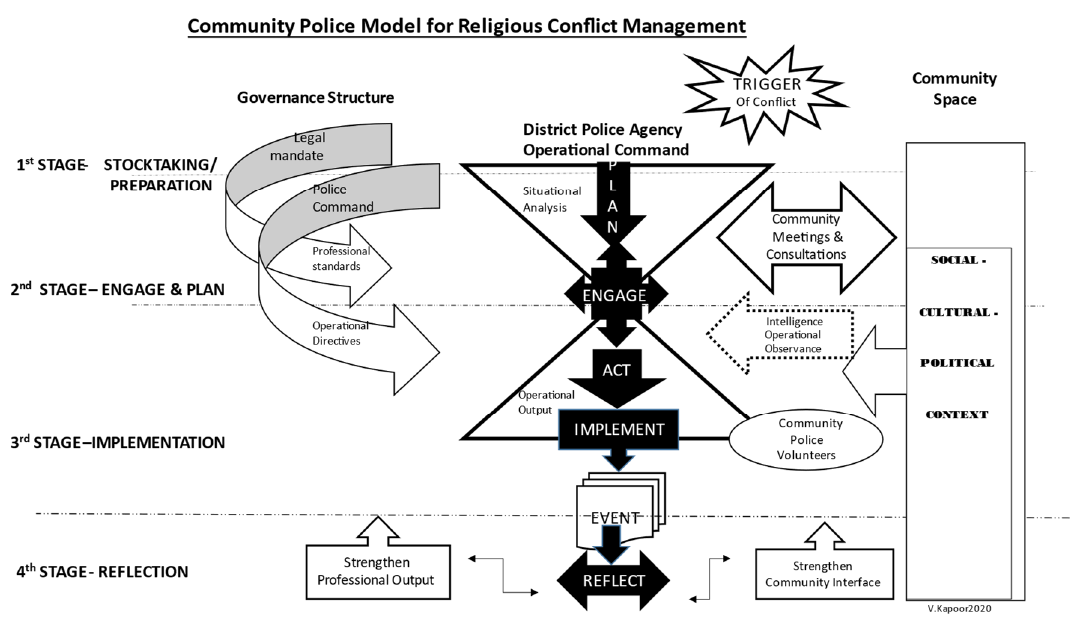
Figure 3. SP’s Diagram of the Police Operation.